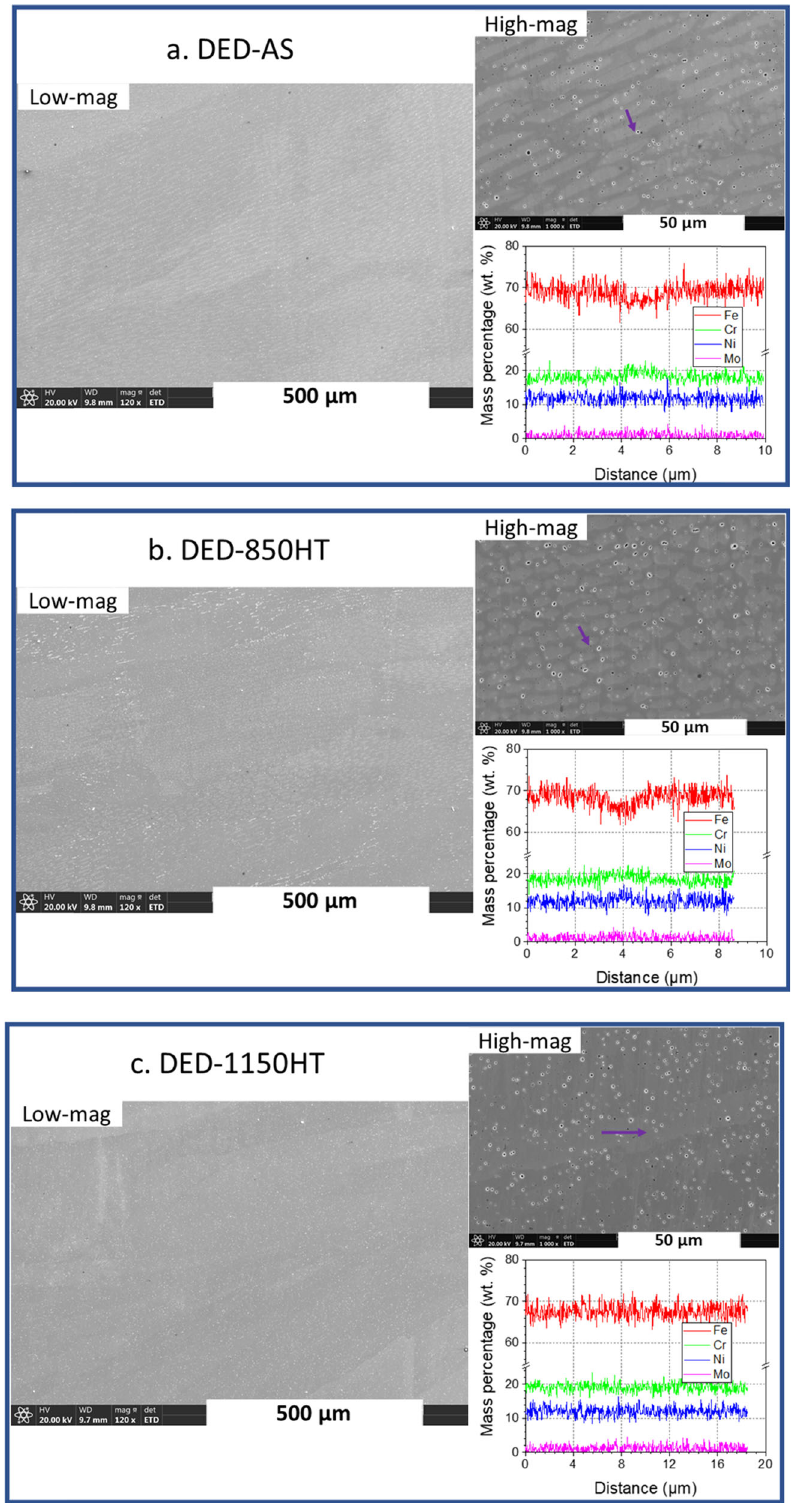
Fig. 3 SEM-EDS results. SEM surface morphologies and corresponding EDS line scanning results of the as-manufacture and heat-treated DED 316L SS: a DED-AS, b DED-850HT, and c DED-1150 specimens. The building direction is from left to right. The EDS line scanning positions are marked as purple arrow